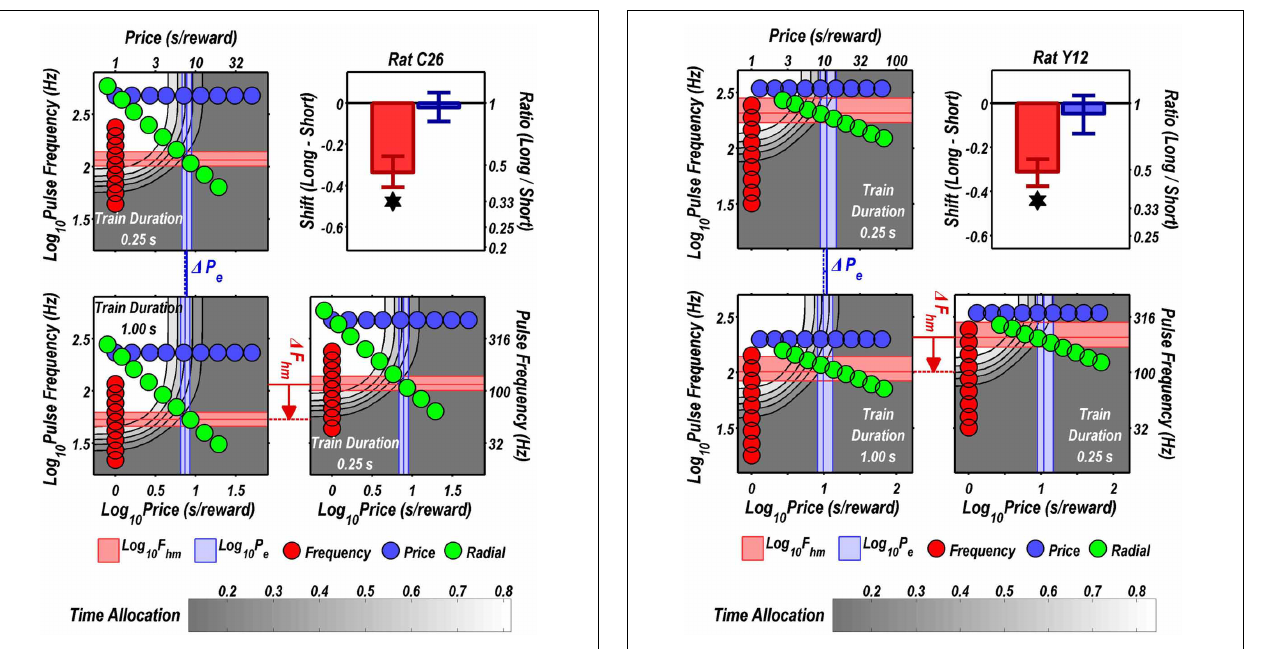
FIGURE 4 | Shifts of the reward mountain. The contour graph for the long-duration(1s)trainisshowninthelowerleft.Forcomparisonthecontour graph for the short-duration (0.25s) train is shown twice, in the upper left and lower right. The P e parameter determines the location along the price axis, whereasthe F hm parameterdeterminesthelocationofthemountainalongthe pulse-frequencyaxis.Theverticalbluelinerepresentstheestimateof P e ,and thesurroundingbandrepresentsthecorresponding95%confidenceinterval. The horizontal red line represents the estimate of F hm , and the surrounding band represents the corresponding 95% confidence interval. The bar graph shows the mean shifts in the location parameters due to the increase in train durationfrom0.25to1salongwiththeassociated95%confidenceintervals. ∗ Indicates that the 95% confidence interval does not include zero.